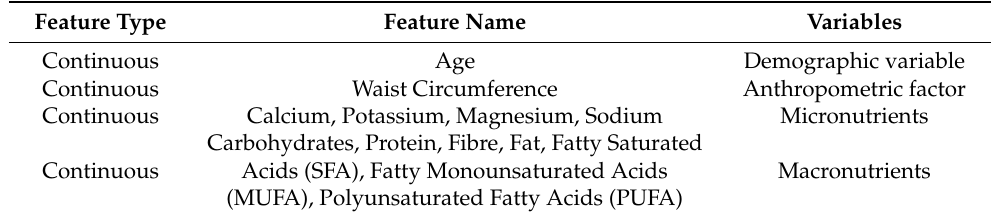
Table 1. Features